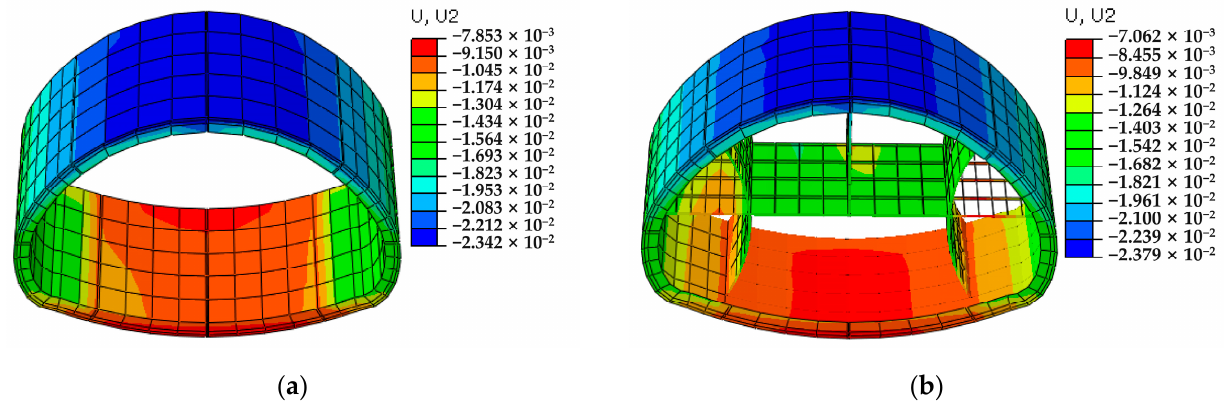
Figure 21. The vertical displacement of lining after the construction of the secondary lining (unit: m): ( a ) Condition 1 and ( b ) Condition 2.